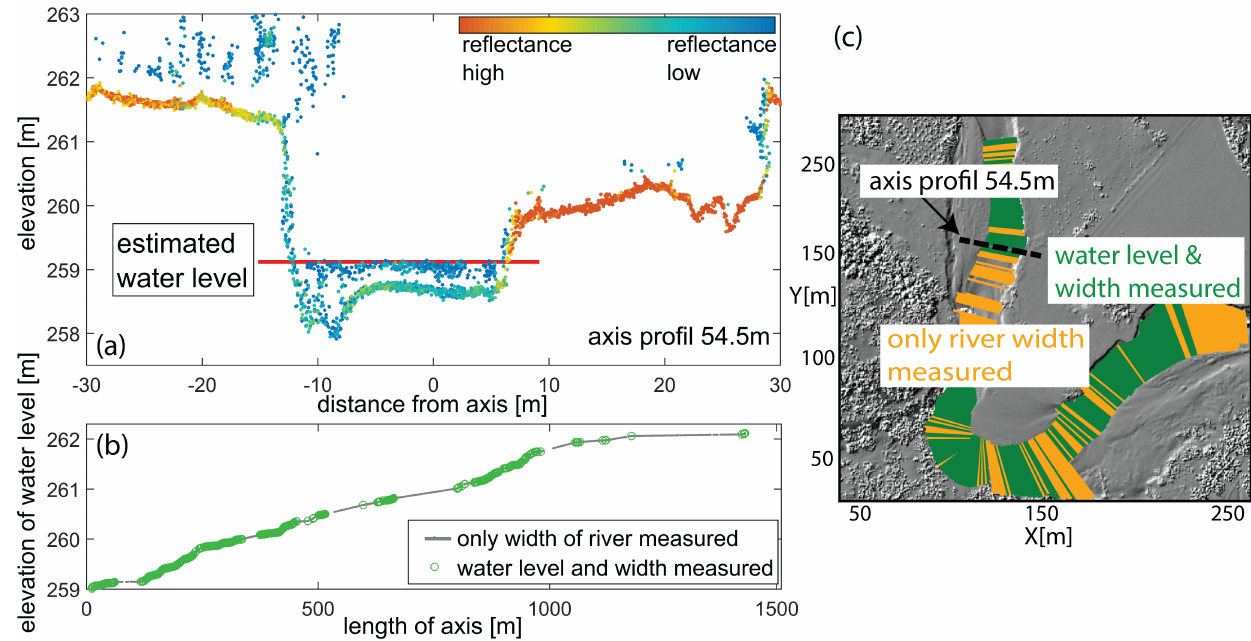
Figure 4. Semi-automatic derivation of water surface model; ( a ) cross section with LiDAR echoes colored by reflectance and manually defined water level and extent (red line); ( b ) longitudinal section with measured water levels (green circles) and/or extents (gray dots); ( c ) plan view, measured sections marked in